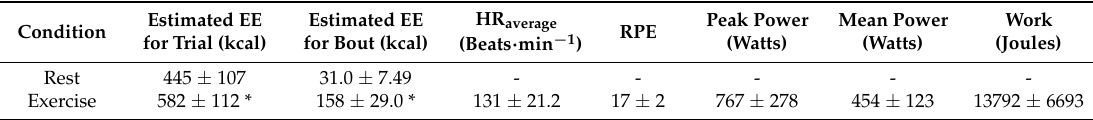
Table 1. Characteristics of the exercise and rest